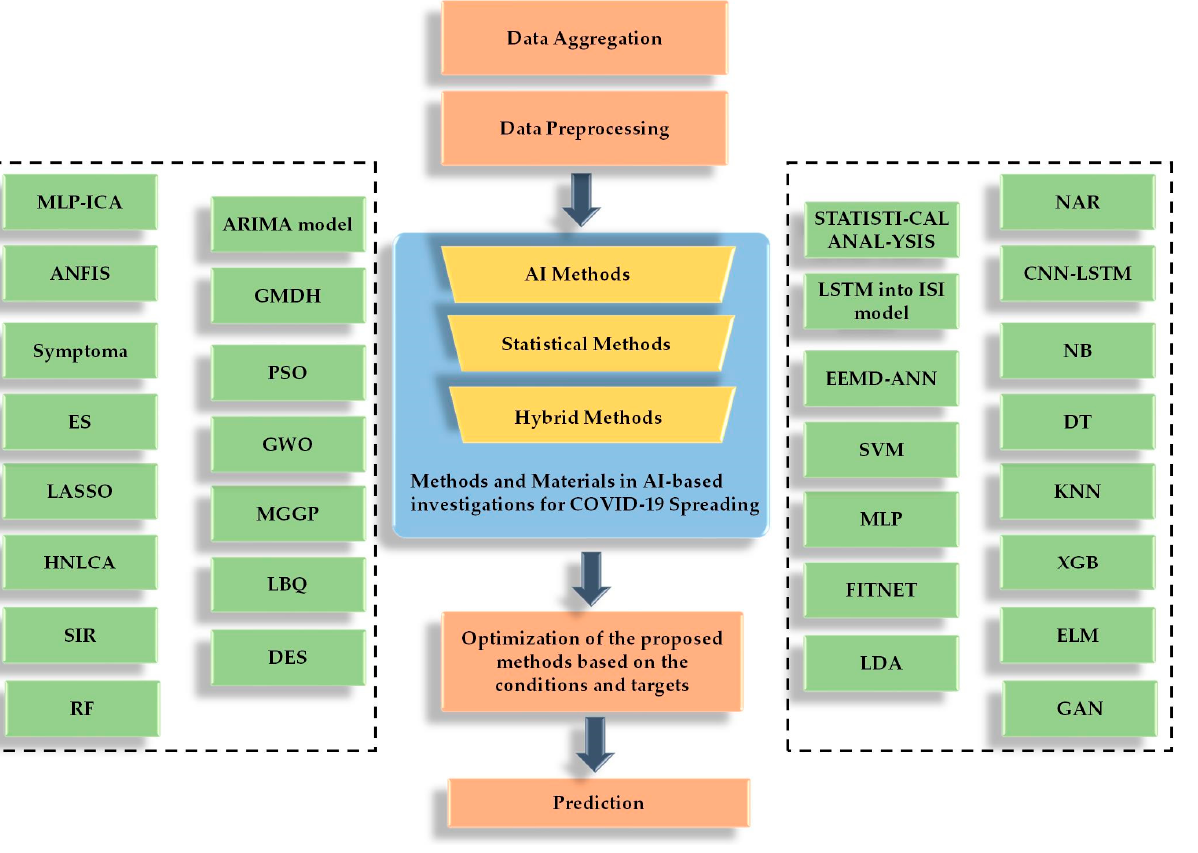
Figure 1. AI-based methods and techniques have been used for predicting COVID-19 spreading. The right side of the figure demonstrates purely AI methods without combination with statistical ones while the left side brings the hybrid methods and purely mathematical techniques used for analyzing complex phenomena.